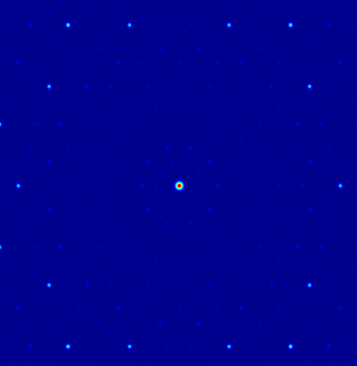
Figure 9. Diffraction pattern of the Penrose QC obtained from the FS expansion of a 4D hyper-lattice with ( 2 11 + 1 ) 4 = 279,841 terms. The magnitude of the Fourier harmonics is plotted versus the × parallel space component of the RVs.